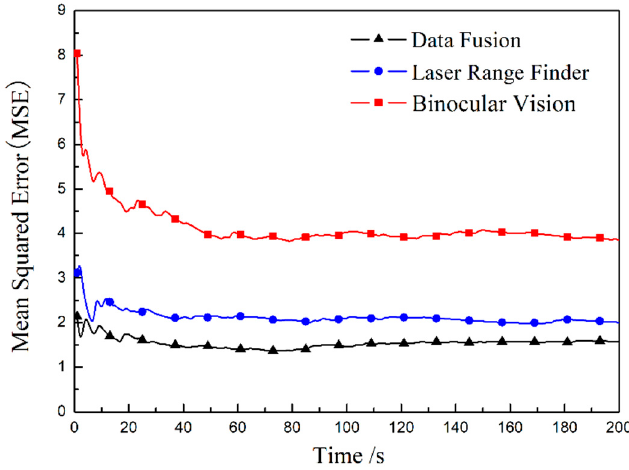
Figure 6. The mean squared error (MSE) of sensors and fusion results.